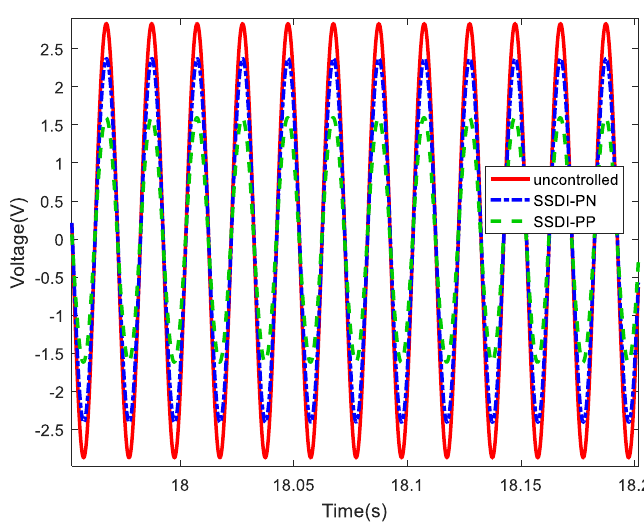
Figure 14. Comparison of displacements in three cases (50 Hz, phase difference 180 degree).